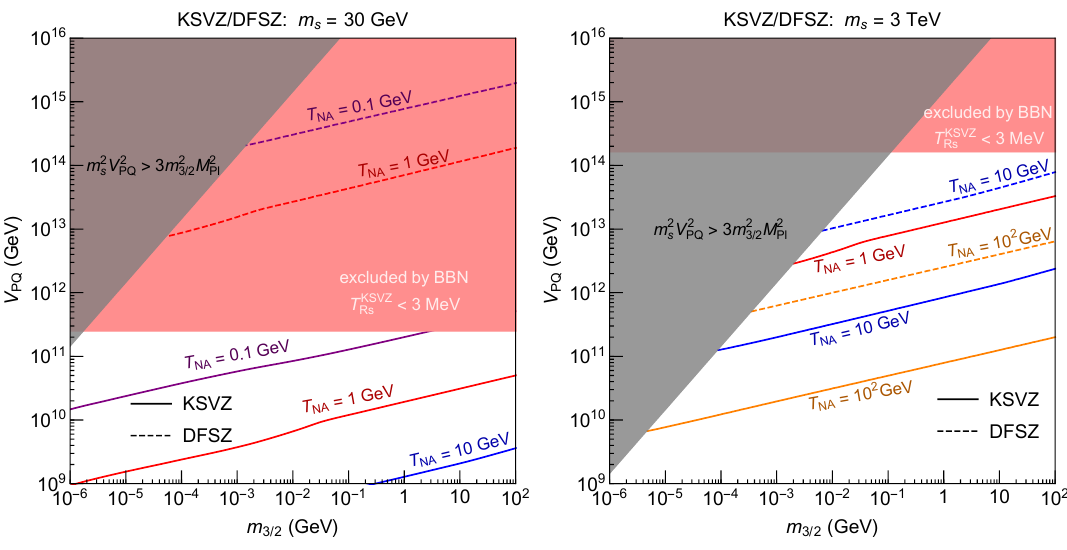
Figure 2 . The maximal parameter space for thermalized gravitino dark matter. In the left panel, m s = 30 GeV and saxion decay is dominated by s gg ( s b (cid:22) b ) for KSVZ (DFSZ with (cid:22) = 4 TeV). ! ! In the right panel m s = 3 TeV and in KSVZ theories s gg dominates while in DSFZ theories ! with (cid:22) = 2 TeV s WW; ZZ; hh dominates. For both panels, the red region excluded by BBN ! applies only to KSVZ theories. We set N DW = 1 for